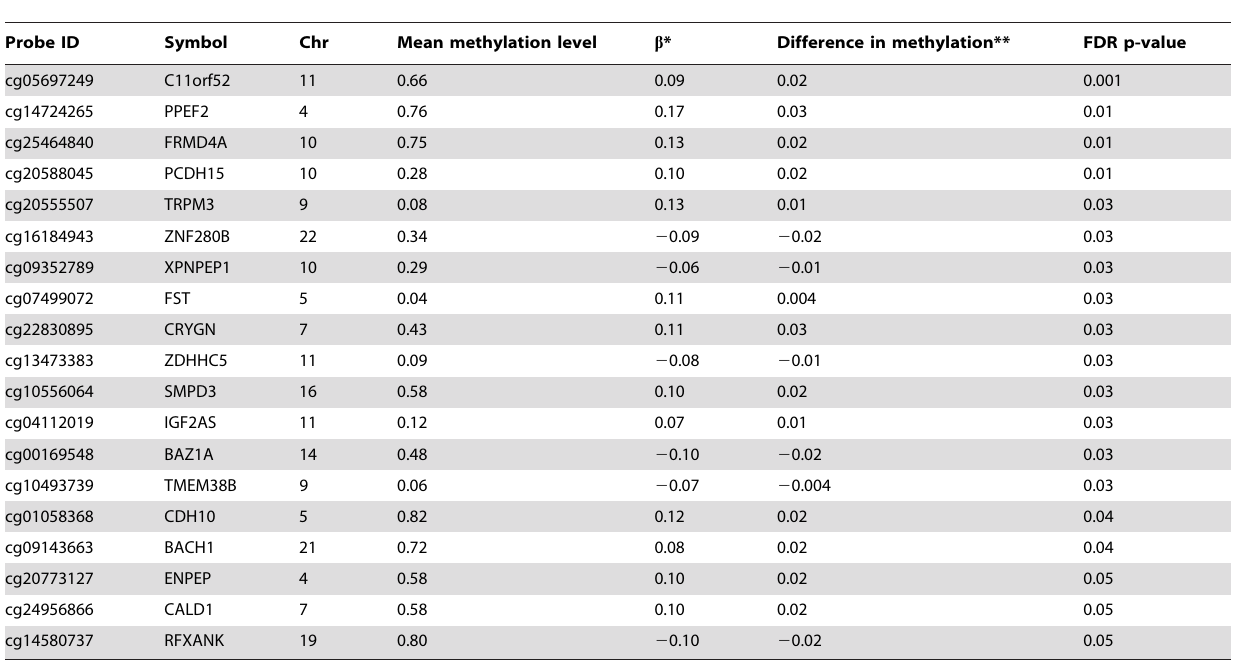
Table 2. CpG Loci significantly associated with IUS exposure in CAMP asthmatics (N=527).